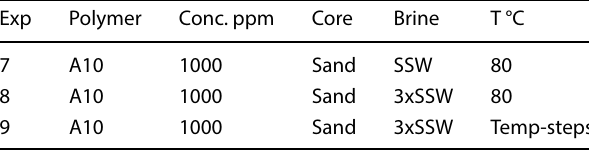
Table 2 Overview of Experiment 7 to 9, conducted with a 76 cm long unconsolidated sand pack in steel tube Exp